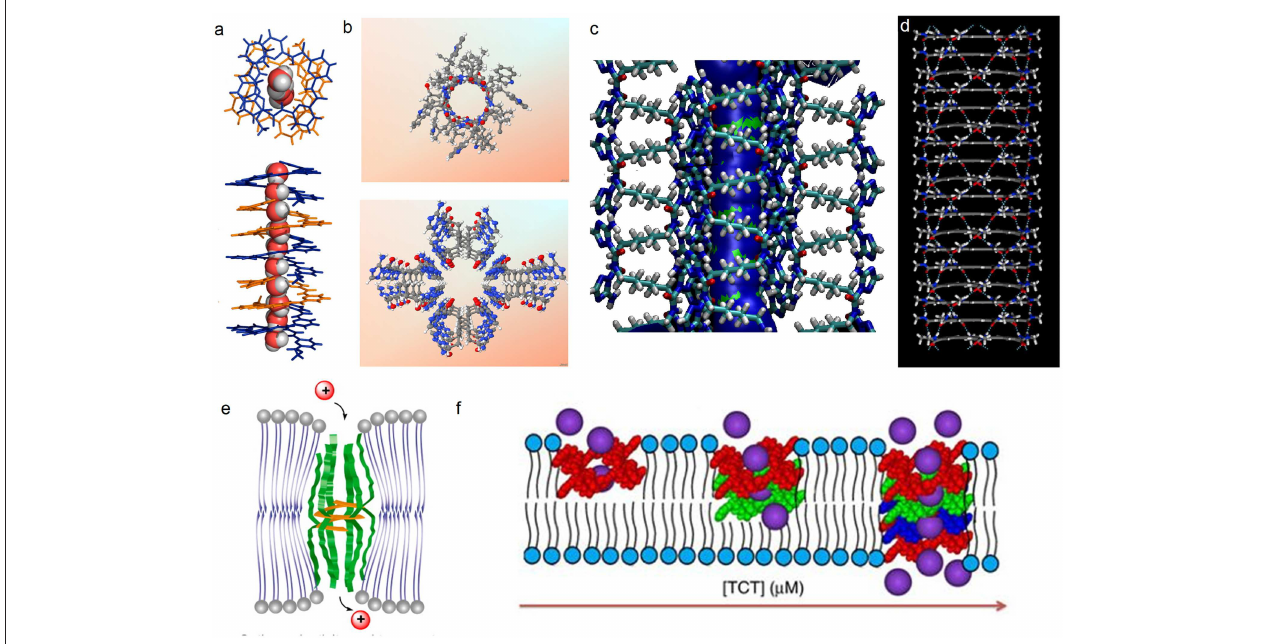
FIGURE 2 | (a) Single crystal structure of 1 and the accompanying water wires; (b) X-ray crystal structures of gA (top) and the hydrophilic T-channel of triazole 3 (bottom) at the same dimensional scale, (c) Probability plots describing the average distribution of water molecules confined within the T-channels (d) simulated hydrophobic tubular pores from macrocycle 4 . Schematic representation on reconstitution of (e) 2b and 2c and (f) 3 in bilayer membrane models.